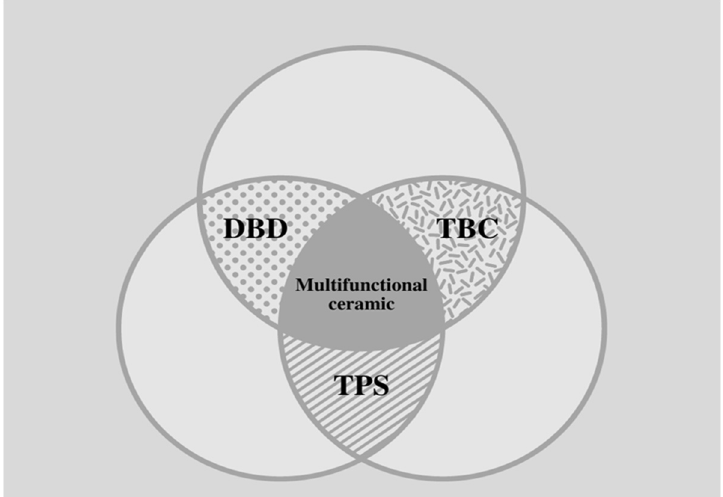
Figure 8. Ceramic systems proposed by the literature and likely possible applications in aeronautical and aerospace